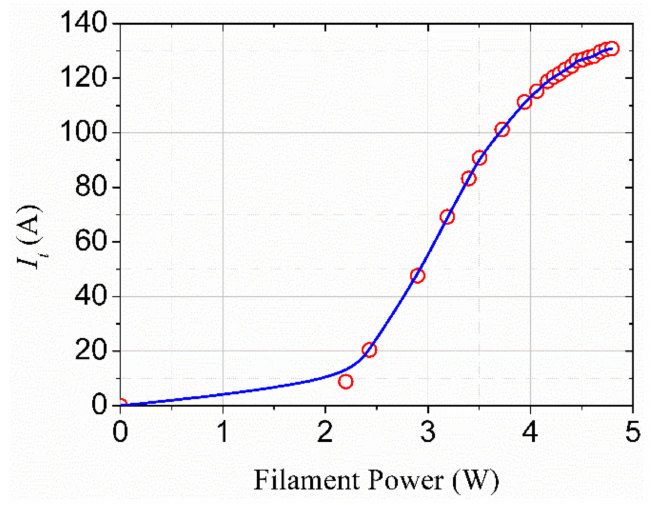
Figure 12. The emission current of the Scandate cathode as a function of the filament power.